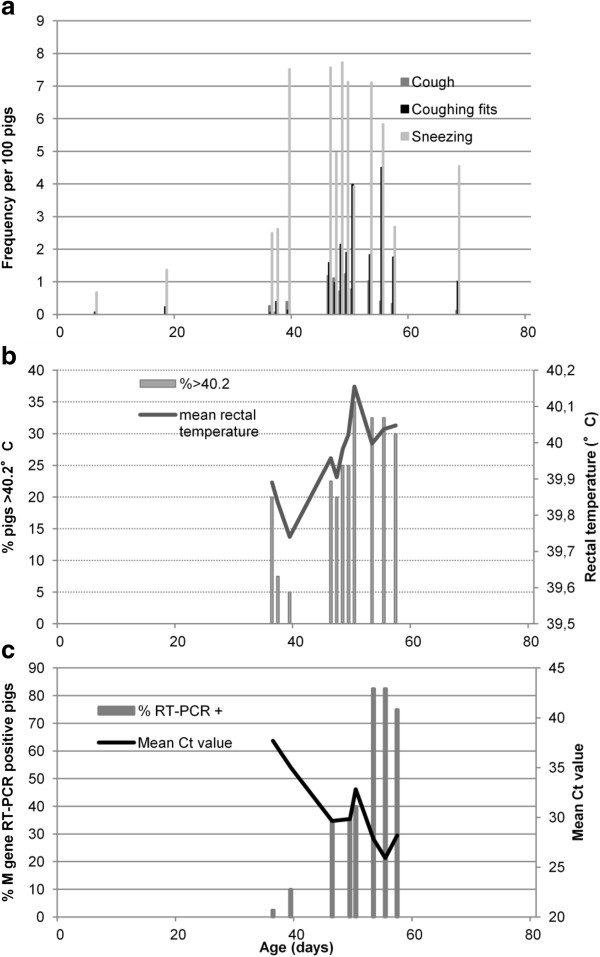
Correspondence between clinical (cough, sneezing, rectal temperature) and virological data in a typical influenza outbreak (Farm#C, batch#2, nursery period). (a): frequency of sneezing, cough and coughing fits for 100 pigs (mean value of 3 counts, 2 minutes each). (b): mean rectal temperature of the 40 monitored piglets (solid grey line) and frequency of piglets above 40.2 °C (grey bars). (c): percentage of M gene RT-PCR positive piglets (grey bars) and mean Ct value (solid grey line).